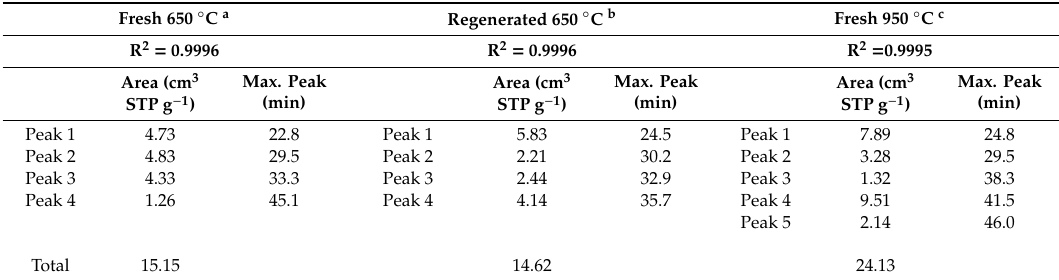
Table 5. TPR analysis of the Fe x O y / CaO- γ -Al 2 O 3 catalyst of the present